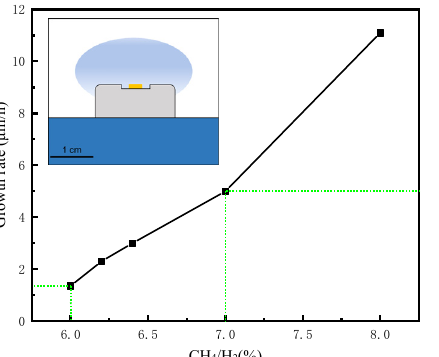
Figure 1. The growth rate of diamond versus CH 4 /H 2 ratio (Samples’ position (yellow) is shown in the inset).